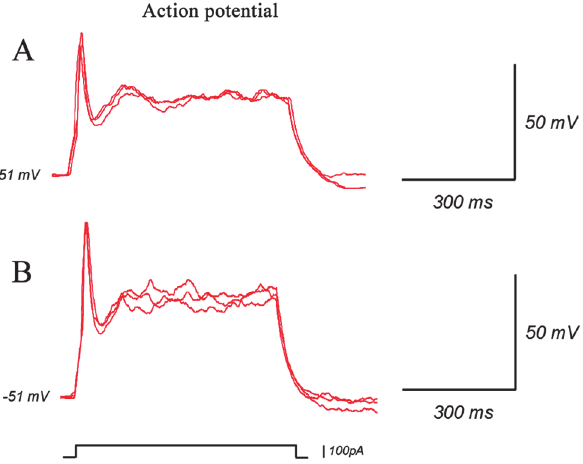
Fig 8. Electrophysiological function of differentiated neurons. The neurons differentiated from iNSCs exhibited functional membrane properties. Whole-cell patch-clamp recordings showed action potentials of iNSCs-derived neurons (B) which is similar to wt-NSCs (A).